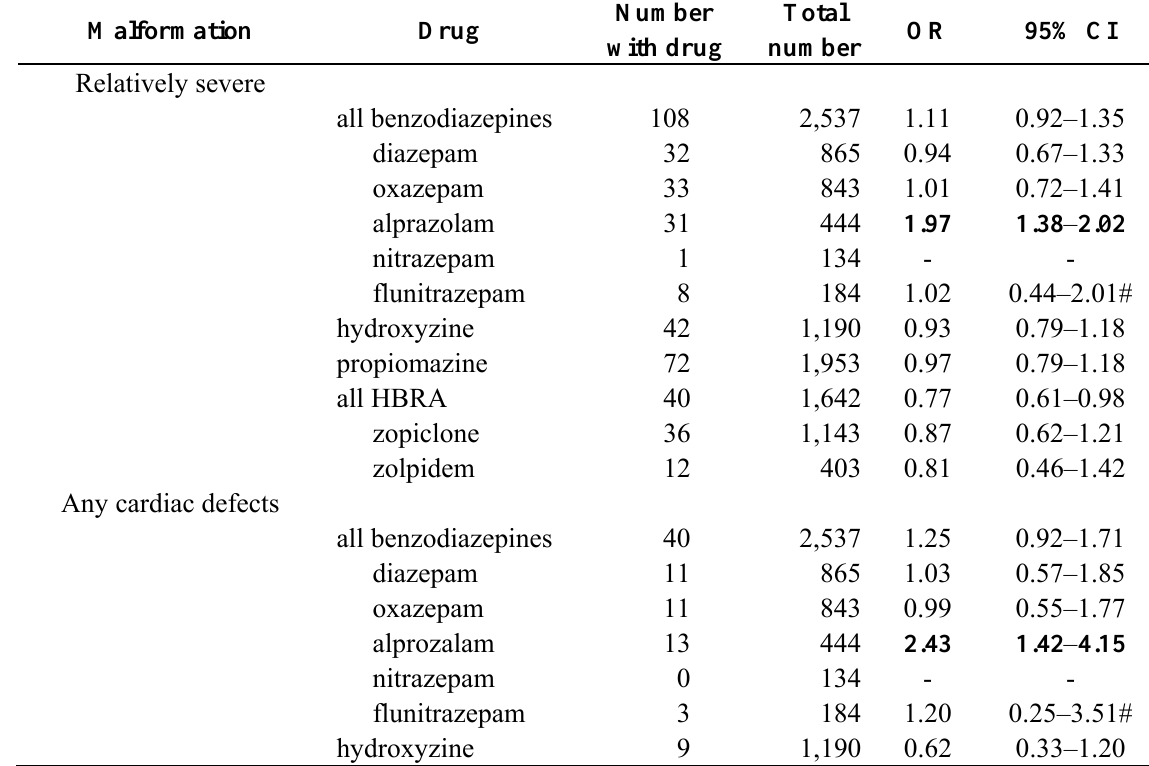
Table 25. Congenital malformations in infants whose mothers had used some specific sedatives or hypnotics. Bold text marks statistical